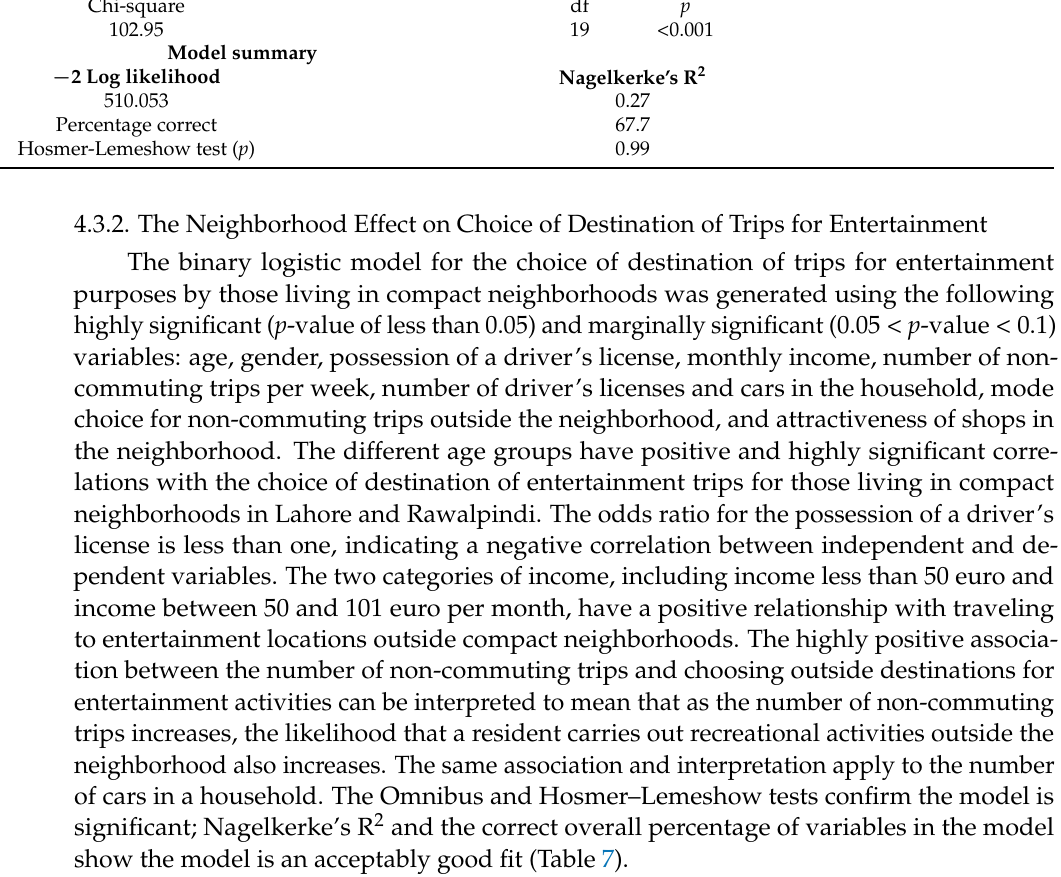
Table 7. Binary logistic model for choice of destination of entertainment location for residents of compact districts.